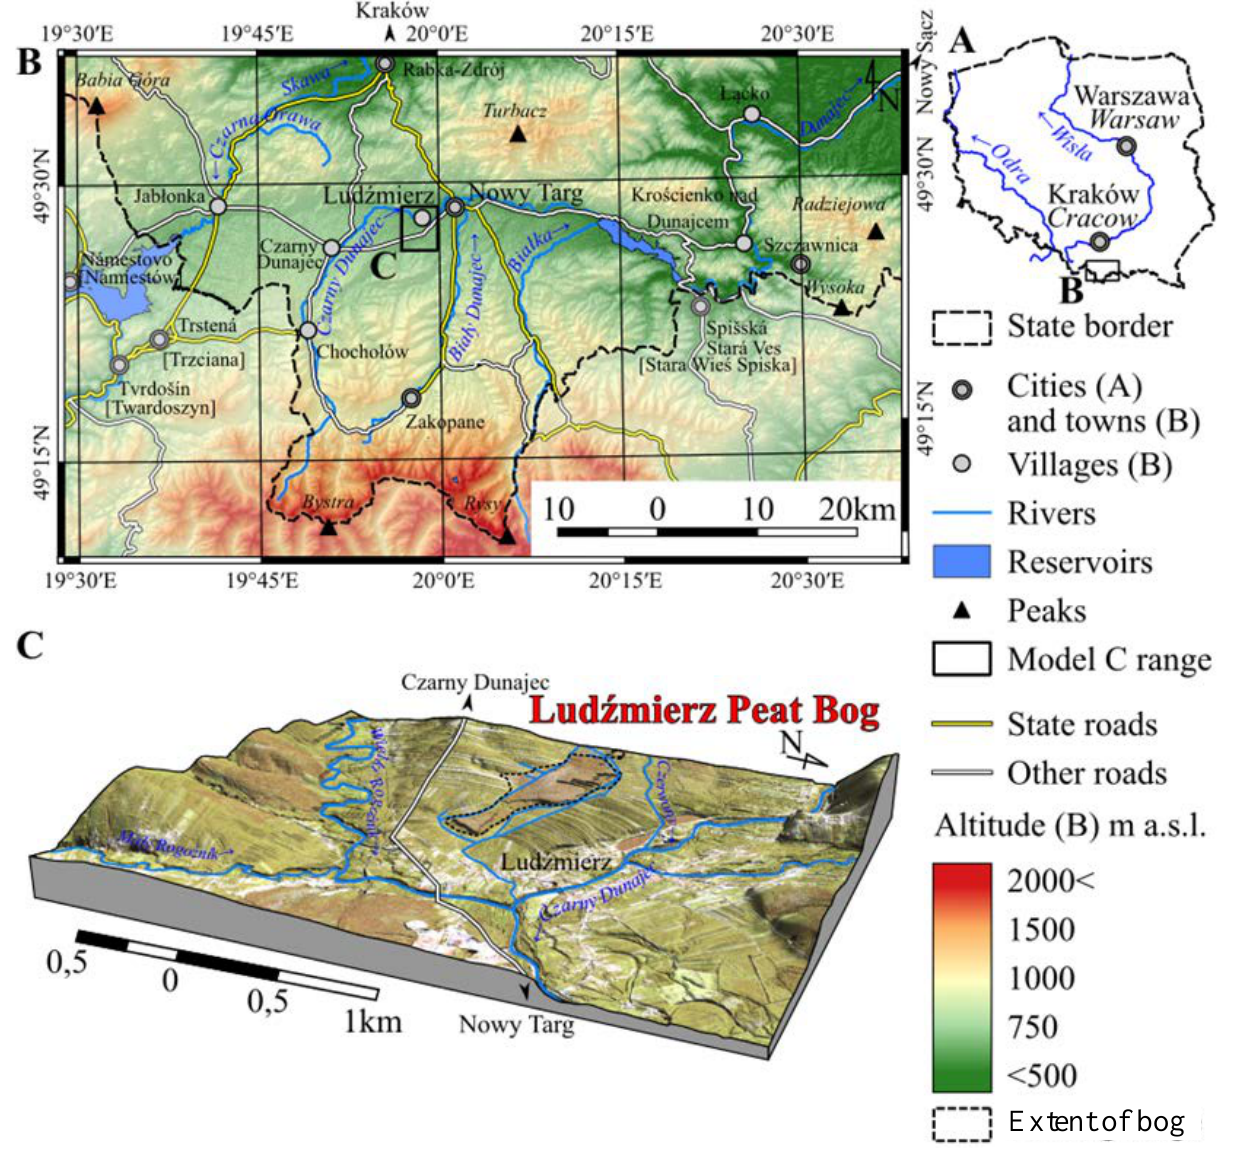
Figure 2. Location of the study area in Poland (A), in the Orawa - Nowy Targ Basin (B) and near the village of Ludźmierz